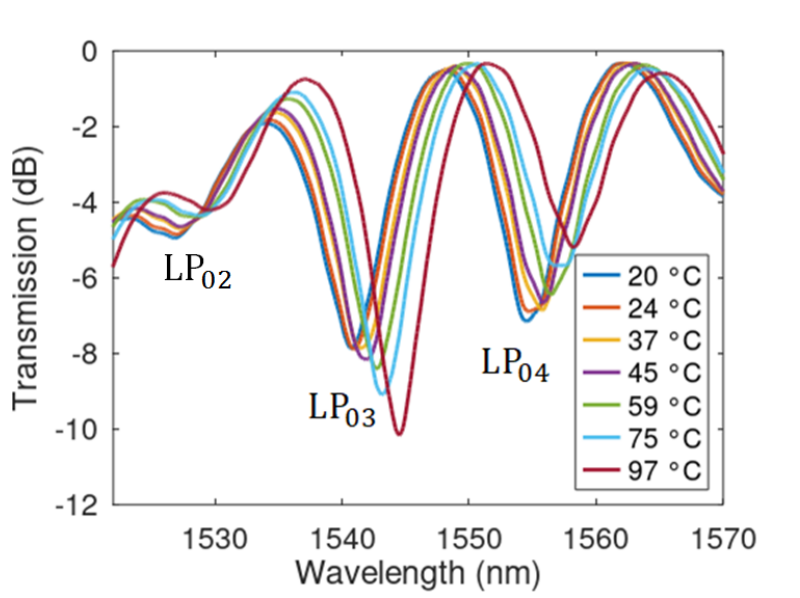
Figure 9. Transmission spectrum of the fabricated LPFG at different temperatures.